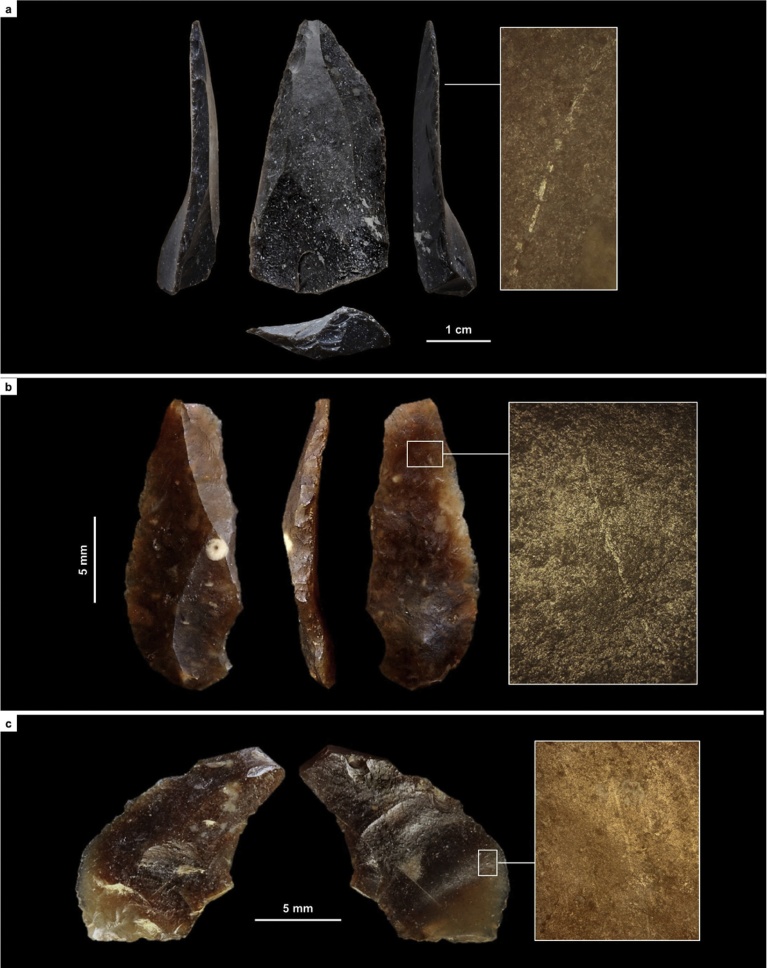
Projectile technology across the Middle-to-Upper Paleolithic transition in the Mula basin sites. Axial points in the Mousterian, composite points armed with cutting, laterally mounted, microlithic elements in the Aurignacian. a. Mousterian point from Finca Doña Martina (layer 9). b. marginally backed bladelet from La Boja (OH16). c. Dufour bladelet from Finca Doña Martina (layer 8). The insets show characteristic microscopic striations generated by impact (for additional detail, see the SI appendix).